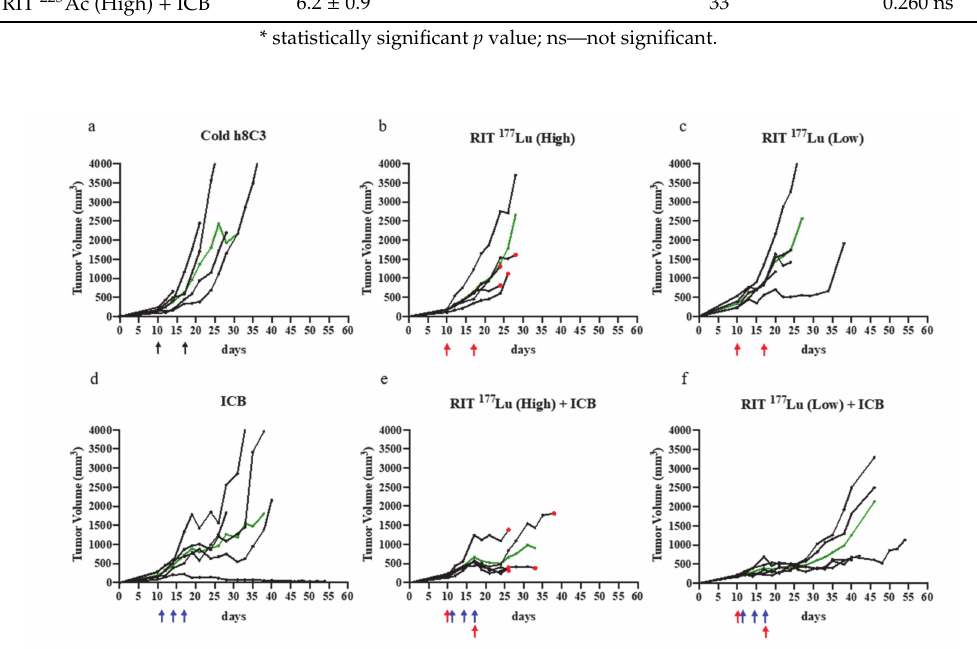
Figure 2. Combination study of anti-PD1 mAb vs. RIT with 177 Lu-h8C3 mAb. The mice in groups of five were treated with: ( a ) two doses of unlabeled (cold) h8C3 anti-melanin mAb on day 10 and 17 after S91 Cloudman tumor cell inoculation; ( b ) two doses of 200 µ Ci (High) of 177 Lu-h8C3 mAb on day 10 and 17 (RIT 177 Lu High); ( c ) two doses of 100 µ Ci (Low) of 177 Lu-h8C3 mAb on day 10 and 17 (RIT 177 Lu Low); ( d ) three doses of 250 µ g anti-PD1 mAb on day 11, 14, and 17 (ICB); ( e ) three doses of 250 µ g anti-PD1 mAb on day 11, 14, and 17 with two doses of 200 µ Ci (High) of 177 Lu-h8C3 mAb on day 10 and 17 (RIT 177 Lu High + ICB); ( f ) three doses of 250 µ g anti-PD1 mAb on day 11, 14, and 17 with two doses of 100 µ Ci (Low) of 177 Lu-h8C3 mAb on day 10 and 17 (RIT 177 Lu Low + ICB). Day 0 is the day of tumor cell inoculation. Each black tumor volume curve represents a single animal; green line—median tumor volume in the group. Black, blue, and red arrows indicate the injection of cold antibody, anti-PD1 antibody, and RIT, respectively. Red dots indicate the death of the animal from